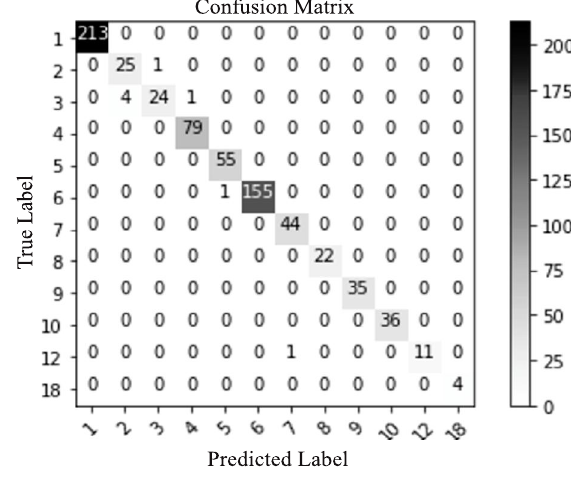
FIG. 8. CONFUSION MATRIX OF RANDOM FOREST ALGORITHM TARGETING CLASS